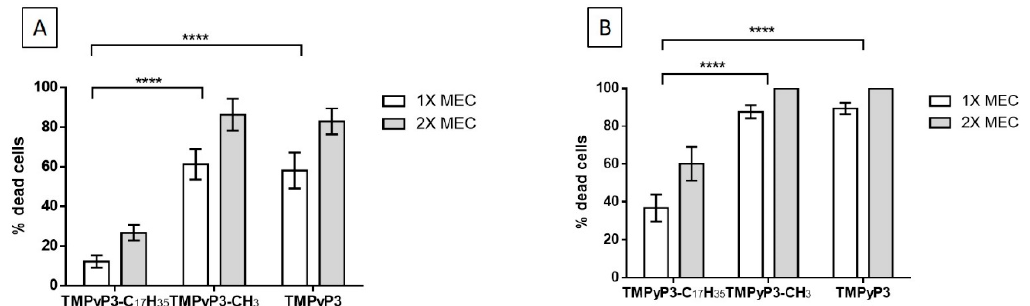
Figure 5. Viability of Legionella pneumophila after 10 min (total dose 12 J / cm 2 ) ( A ) and 30 min (total dose 36 J / cm 2 ) ( B ) exposure to violet light. Data are shown as an average of % dead cells and error bars are representing standard deviation (SD); **** p < 0.0001.